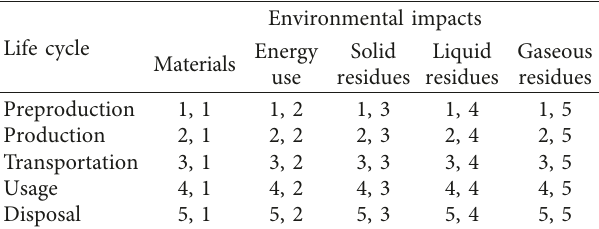
Table 2: 5 × 5 assessment matrix